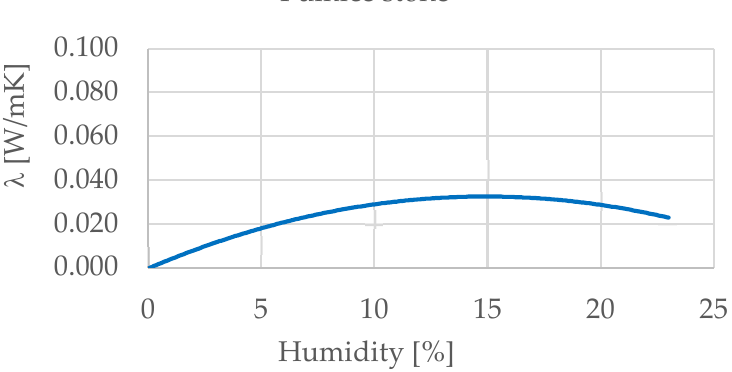
Figure 6. Effect of humidity on thermal conductivity of pumice [author’s figure based on [60]].